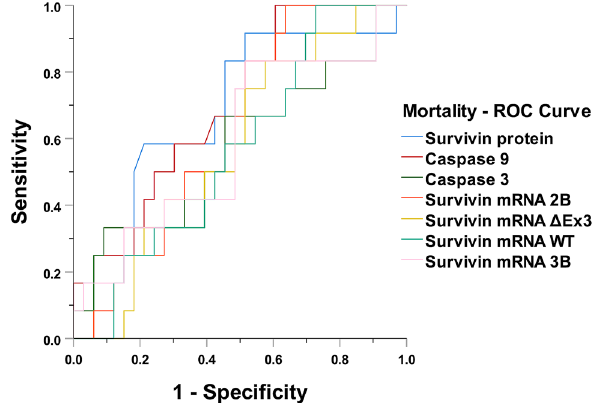
Figure 5. ROC curve for predicting mortality. Caspase-9 and survivin protein achieved the best receiver operating characteristic curve—AUROC of 0.70 (95% CI 0.52–0.88, p <